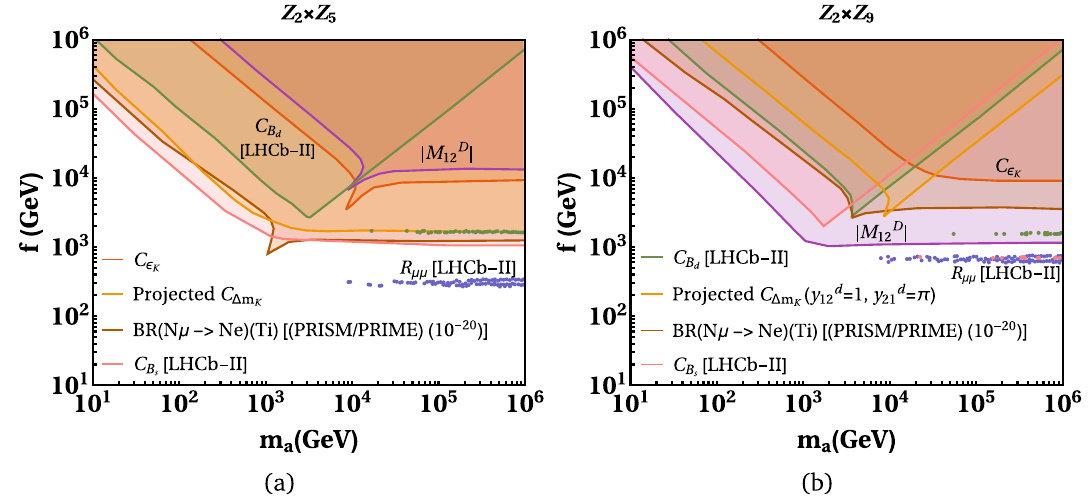
Fig. 15 Summarized significant bounds on the minimal Z 2 × Z 5 and the non-minimal Z 2 × Z 9 model in the left and the right panel